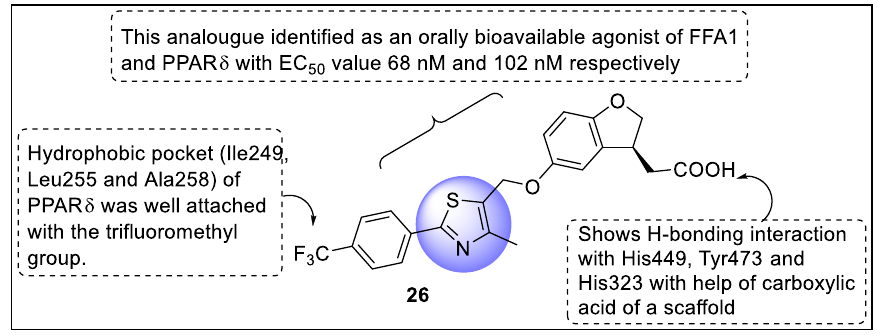
Figure 30. Structural activity relationship of thiazole hybrids ( 26 ) as potent PPAR ligands.